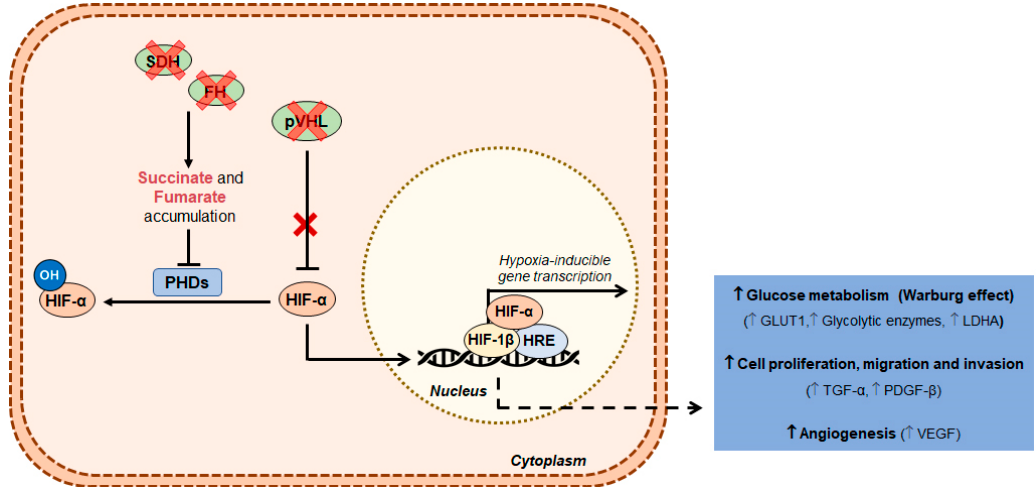
Figure 1. Genetic mutations, HIF-1 α activation and metabolism of RCC. Succinate and fumarate accumulation, as well as VHL inactivation leads to increased glycolytic metabolism by HIF pathway activation. Abbreviations: FH, Fumarate hydratase; GLUT, Glucose transporter; HIF, Hypoxia-inducible factor; HRE, Hypoxia-response elements; LDH, Lactate dehydrogenase; PDGF, Platelet derived growth factor; PHD, Prolyl hydroxylases; pVHL, VHL protein; SDH, Succinate dehydrogenase; TGF, Transforming growth factor; VEGF, Vascular endothelial growth